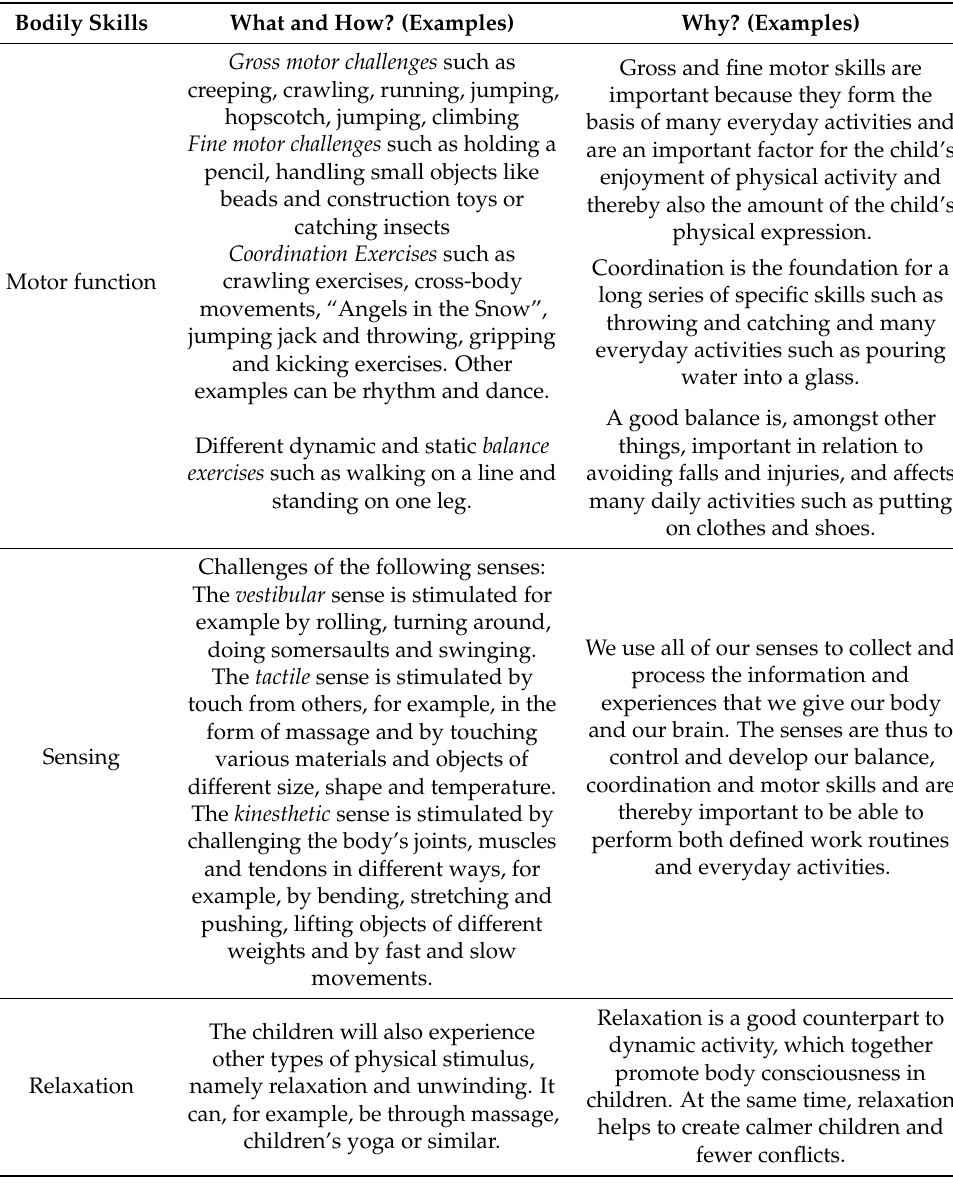
Table 1. At least four days a week, and preferably five, a minimum of 45 minutes adult-initiated and adult-led activities must be carried out, where all children participate. During the week, the following bodily skills must be